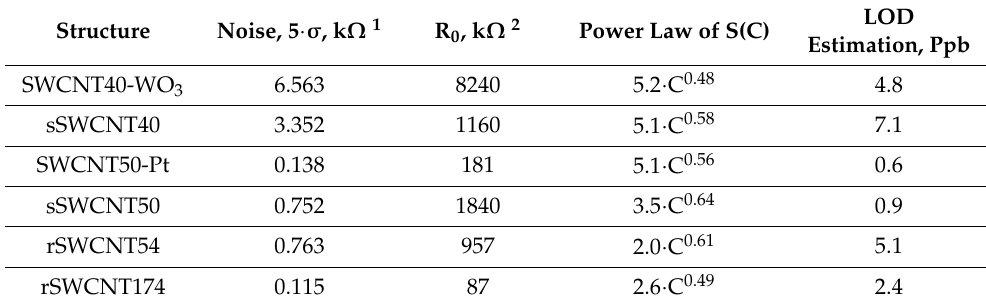
Table 1. The sensing characteristics of the sensor structures under